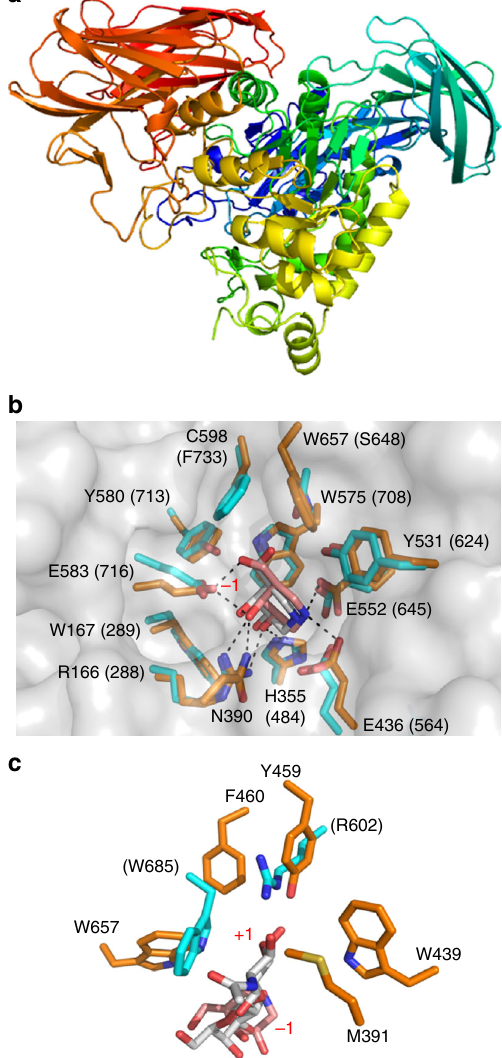
Fig. 5 Molecular basis of the exo- acting β -1,4- D -agarooligosaccharide hydrolase, GH2C. a Structure of GH2C shown in cartoon format color ramped from N terminus (blue) to C terminus (red). b Surface representation (gray) of the GH2C catalytic pocket (orange) in complex with GIF (pink), overlaid with S. pneumoniae BgaA (cyan) in complex with GIF (gray) (pdb entry 4CU7 52 ). Key GH2C residues are labeled, with corresponding BgaA residues in brackets. The − 1 subsite is indicated and hydrogen bonds are represented by dashed lines. c Structural alignment of GH2C (orange) in complex with GIF (pink) (key residues labeled) with BgaA (cyan) in complex with N -acetyllactosamine (gray) (pdb entry 4CUC 52 ). Subsites are indicated. Residues corresponding to BgaA are shown in